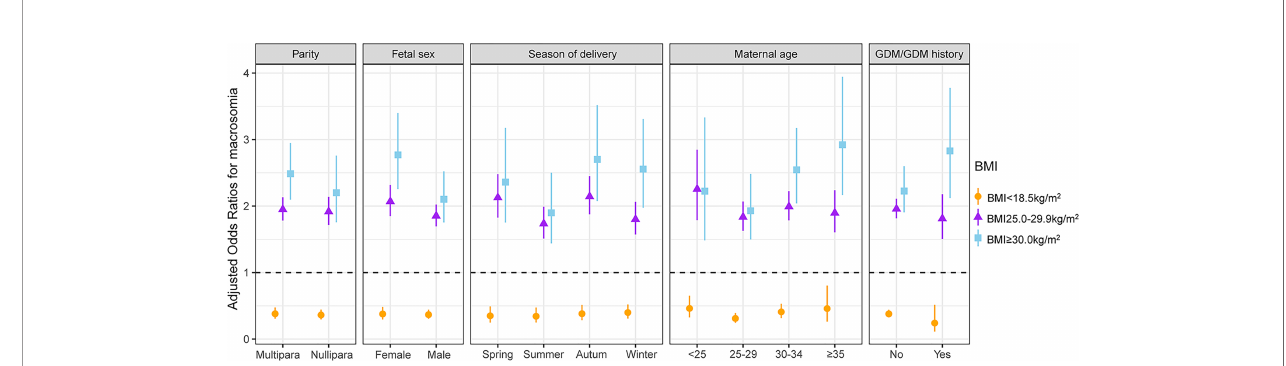
FIGURE 3 | Interactive analyses of the association between maternal fi rst-trimester BMI and macrosomia (each strati fi cation adjusted for all the factors except for the strati fi cation factor itself). All the factors included maternal age, parental ethnicity, parental educational level, parental occupational physical activity, maternal income, parental smoking, maternal secondhand smoke exposure, parental drinking before or during pregnancy, parity, mode of conception, folic acid and multivitamin supplementation, preterm birth, fetal sex, season of delivery, GDM/GDM history, hypertension/hypertension history, and thyroid disease/thyroid disease history. BMI, body mass index; GDM, gestational diabetes mellitus.